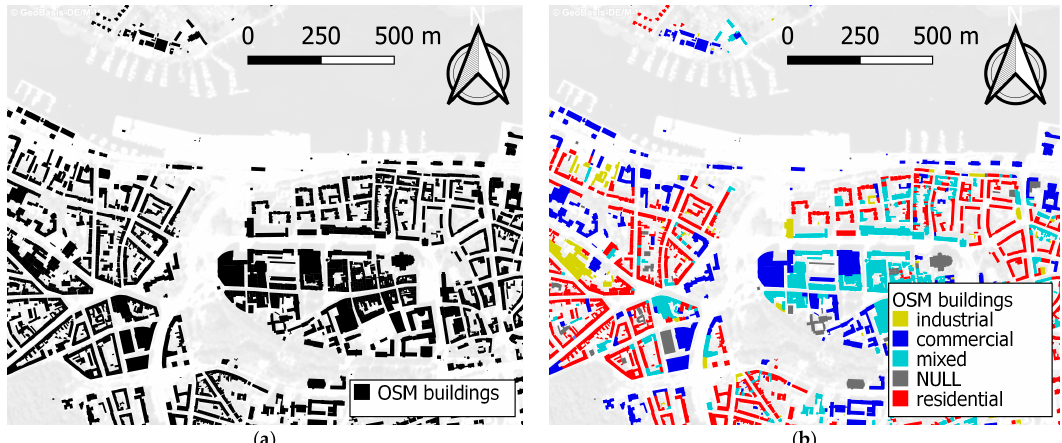
Figure 3. OSM buildings of the Rostock city center: ( a ) before classification and ( b ) after the classification process.